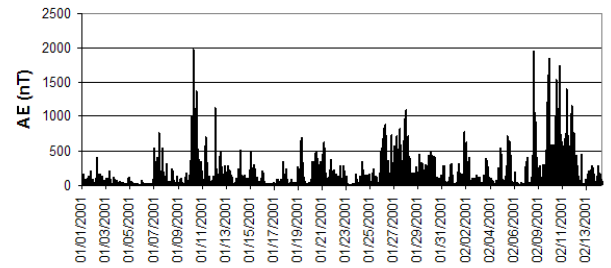
Fig. 2. AL index for the period between 1 January and 15 February 2001 (collected at 1min intervals).